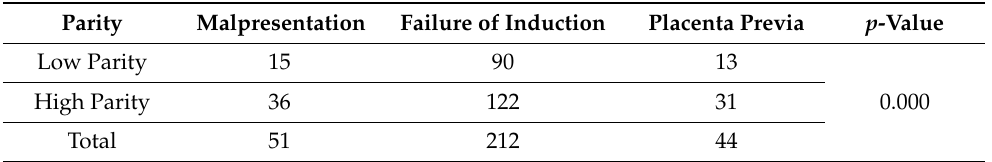
Table 4. Association between women of low parity and high parity with respect to different reasons for LSCS ( n = 307) (Application of Chi-Square test keeping level of significance ≤ 0.05). Parity Malpresentation Failure of Induction Placenta